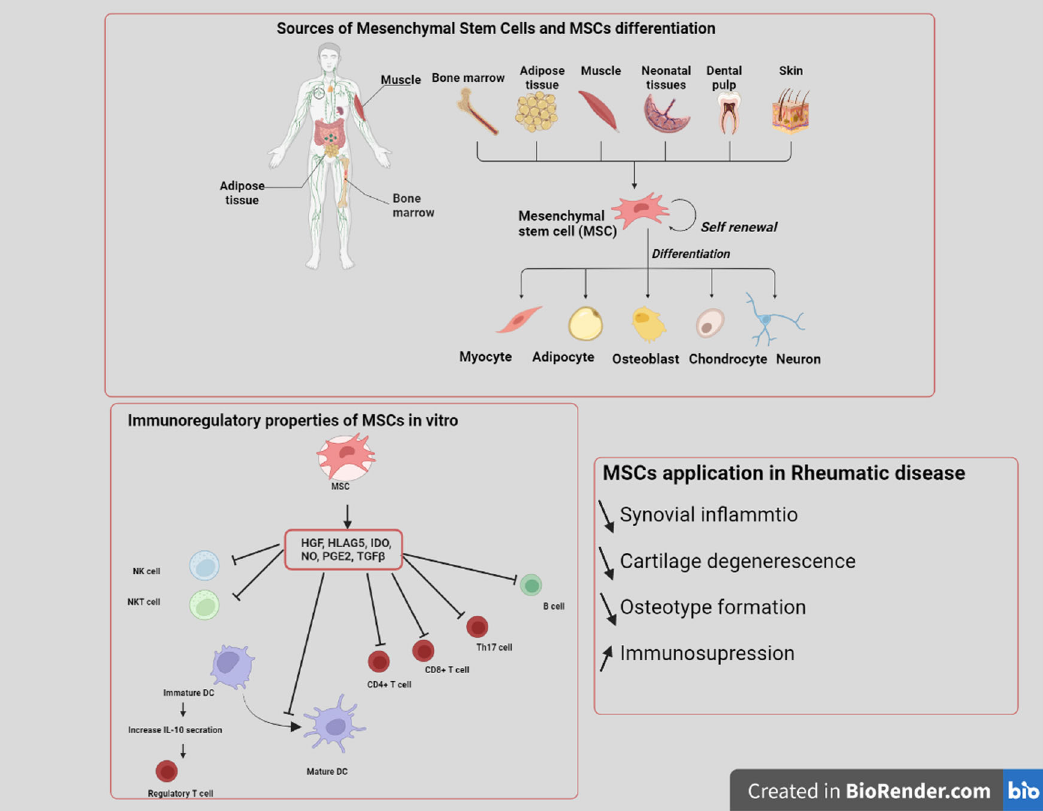
Fig. 1 The properties and applications of mesenchymal stem cells. MSCs are composed of multipotent stem/progenitor cells. Under certain conditions in vitro and in vivo, MSCs may differentiate into distinct lineages. MSCs exhibit signi fi cant anti-in fl ammatory and immunomodulating